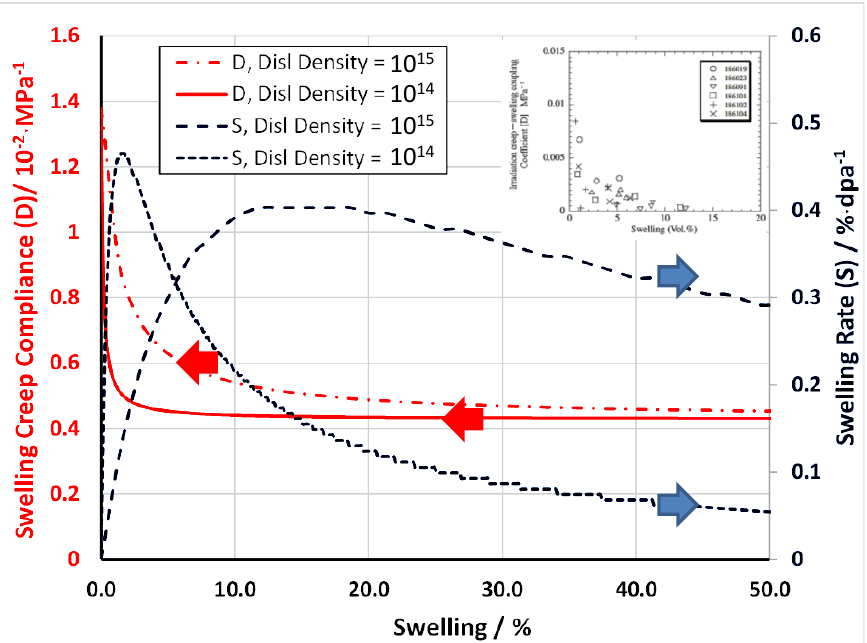
Figure 32. Uniaxial creep (L direction) and swelling for a dislocation density of 10 15 m −2 s = 0.15, p = 0.3. L, T and ST refer to the longitudinal, transverse and short-transverse directions of a typical tensile specimen.